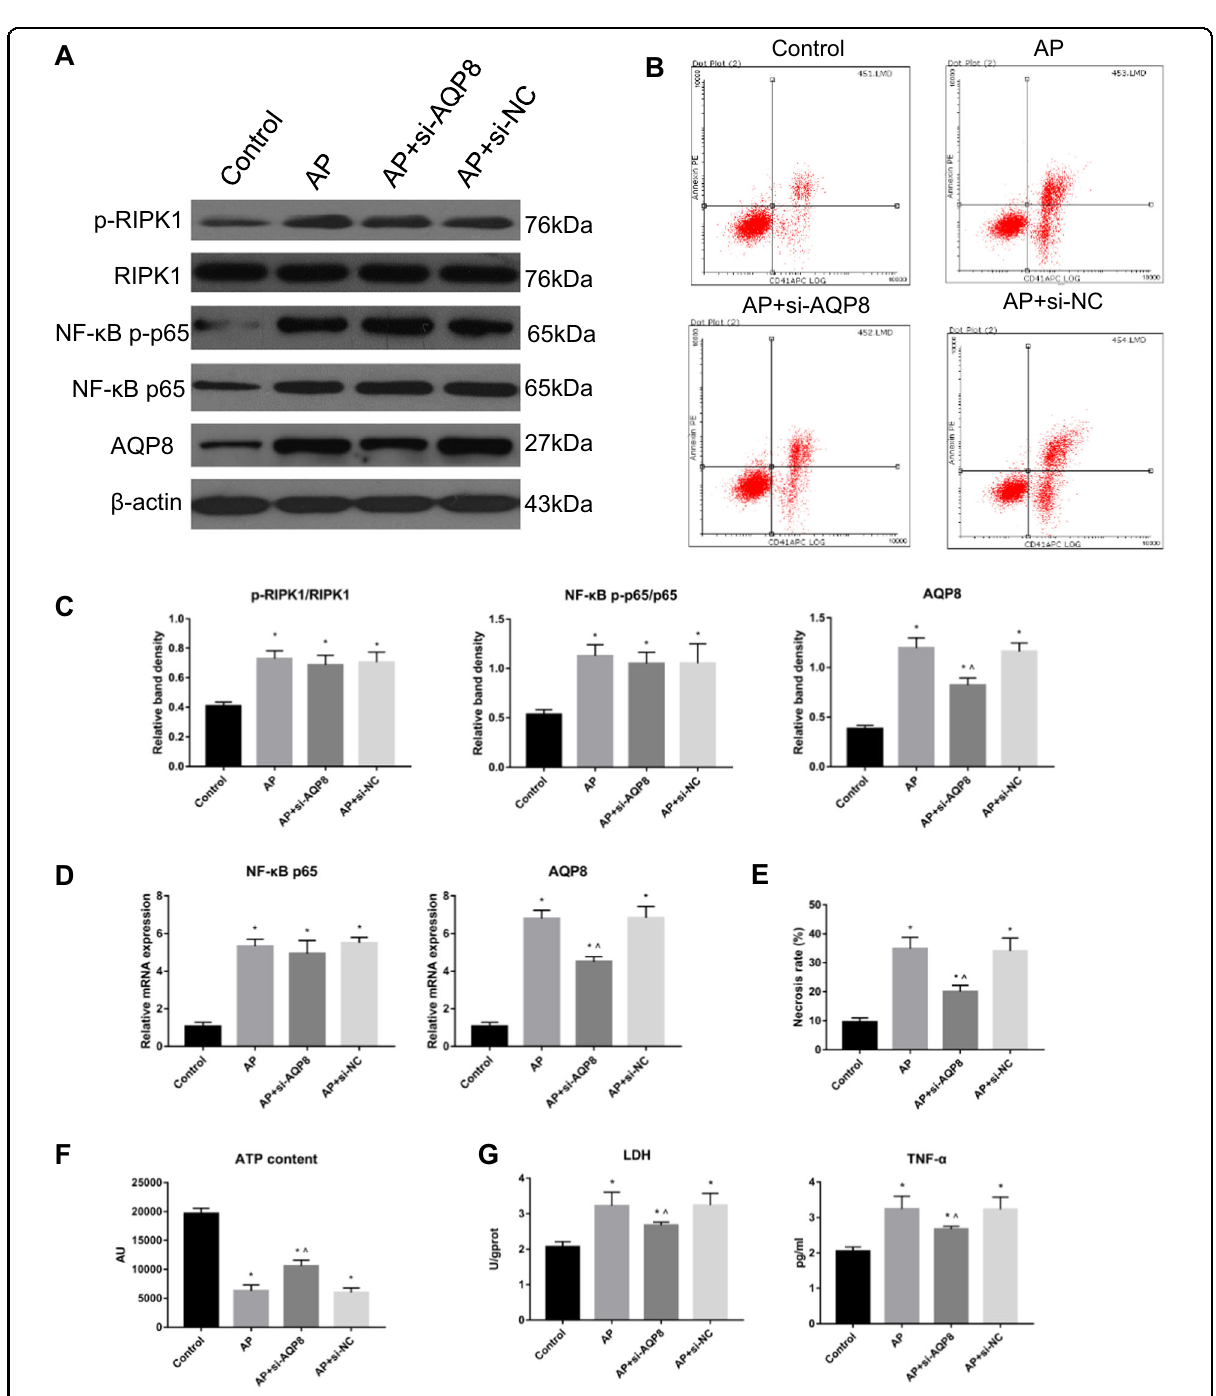
Fig. 6 RIPK1 regulated cell necrosis and in fl ammatory damage in AP through AQP8. a Representative immunoblot images and c quantitation of the p-RIPK1/RIPK1, NF- κ B p-p65/p65, and AQP8 levels in AR42J cells from the Control, AP, AP + si-AQP8 and AP + si-NC groups. β -Actin was used as the protein loading control. b Representative fl ow cytometry results for cell necrosis in the AR42J cells described in Fig. 6a. d Relative mRNA expression of NF- κ B p65 and AQP8 in the AR42J cells described in Fig. 6a. e Histograms showing the necrosis rates of the AR42J cells described in Fig. 6b, as measured by fl ow cytometry. f ATP levels were quanti fi ed in the AR42J cells described in Fig. 6a. g The levels of LDH and TNF- α in AR42J cell culture supernatants as described in Fig. 6a were assessed spectrophotometrically. The data are the means ± S.Ds. ( n = 3). * P < 0.05 versus control, ^ P < 0.05 versus